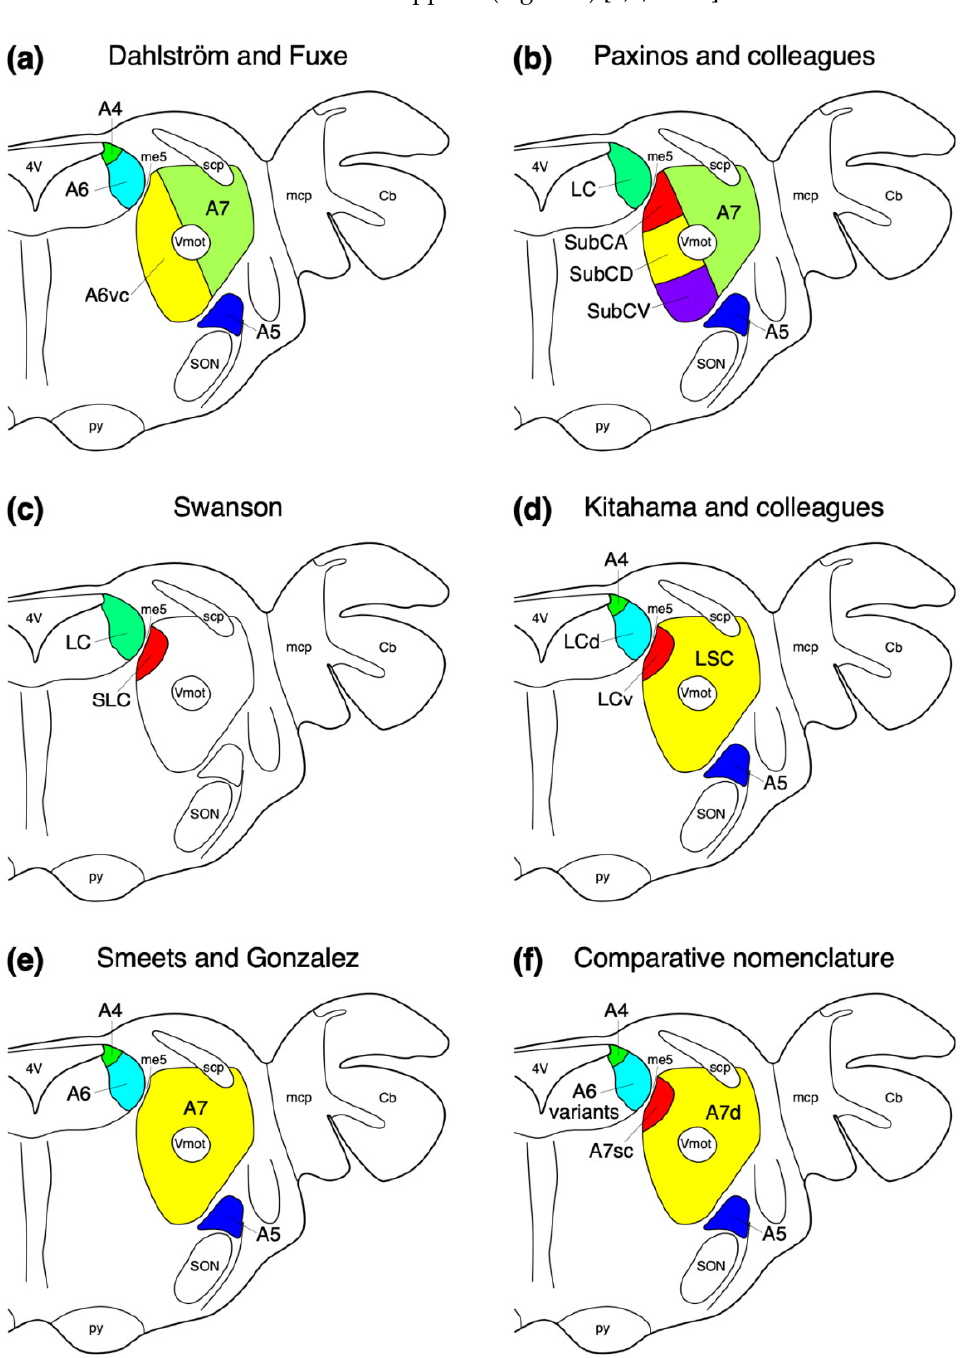
Figure 1. Diagrammatic representations of the parcellation and nomenclature used to describe the locus coeruleus complex in mammalian species in a generalized coronal section through the rostral hindbrain of a mammal. ( a ) The alphanumeric nomenclature applied by Dahlström and Fuxe [2] for the rat brain. ( b ) The combined anatomical and alphanumeric nomenclature applied by Paxinos and colleagues in their rat atlases [63,64]. ( c ) The anatomical nomenclature applied by Swanson [65] in his rat atlases. ( d , e ) The mixed anatomical and alphanumeric nomenclature applied to a limited comparative sample by Kitahama and colleagues [61] and Smeets and González [3]. ( f ) The flexible alphanumeric nomenclature adopted in the current study based on observations made in approxi- mately 80 mammal species from across the phylogenetic breadth of mammals (Table 1). Note how across mammal species in general the same broad organization and distribution of noradrenergic neurons is observed, but the nomenclature based on laboratory rodents is not encompassing and required modification to be applicable across mammalian species. 4V—fourth ventricle; Vmot—tri- geminal motor nucleus; A4—dorsomedial division of the locus coeruleus; A5—fifth arcuate nucleus;